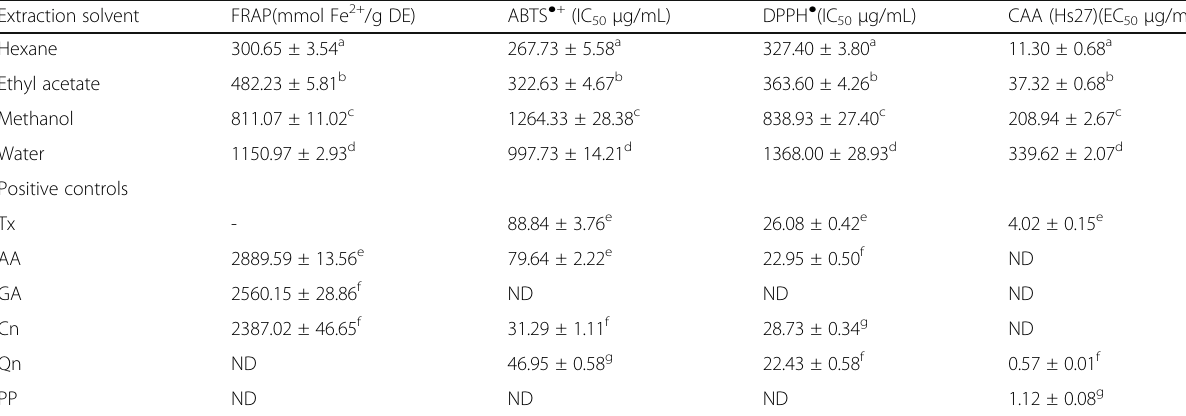
Table 2 Antioxidant activities of MP leaf extracts Extraction